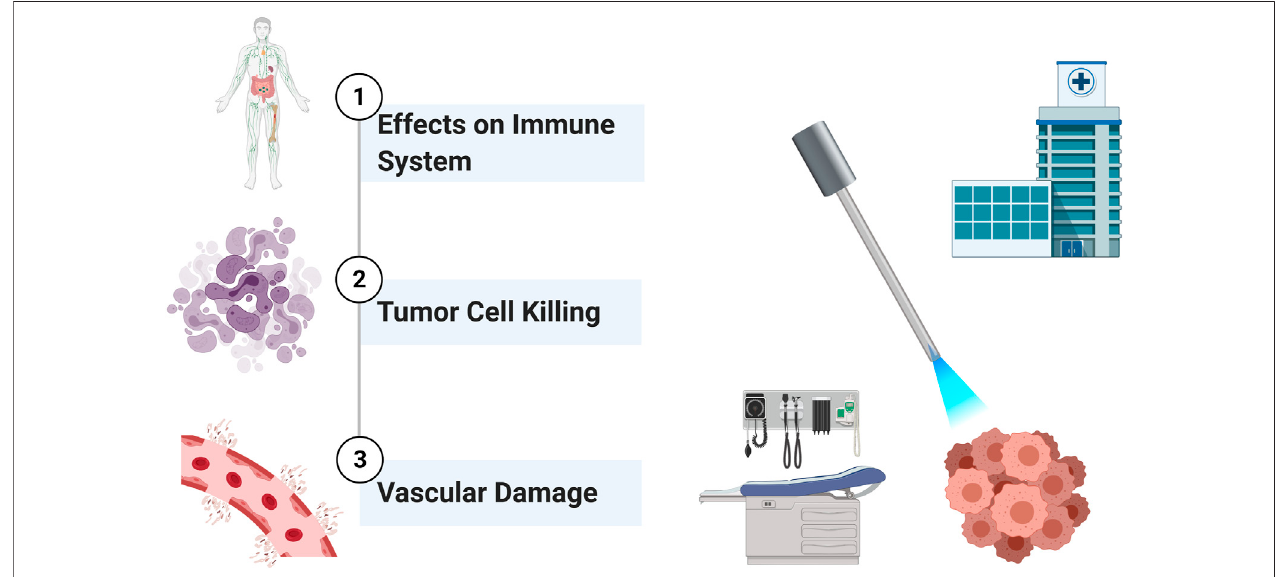
FIGURE 1 | Basic Mechanisms of Action of PDT on Tumors. PDT can exert a plethora of actions such as inducing immune responses, direct killing of tumor cells, and damaging vascular structures.